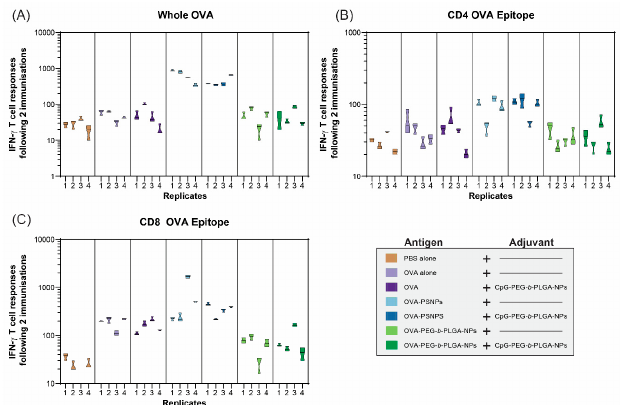
Figure 4. Interferon gamma (IFN- γ ) T-cell responses to nanovaccine formulations at Day 28. C57BL/6 mice were immunized twice, two weeks apart, intradermally at the base of the tail with the following formulations; PBS alone (Naïve), OVA alone, OVA + CpG-PEG- b -PLGA NPs, OVA-PS NPs, OVA-PS NPs + CpG-PEG- b -PLGA NPs, OVA-PEG- b -PLGA NPs, or OVA-PEG- b -PLGA NPs + CpG-PEG- b -PLGA NPs. All animals received 50 µg OVA. CpG-PEG- b -PLGA NP groups received 5 µg CpG. Graph shows IFN- γ T-cell responses to ( A ) whole OVA, ( B ) CD8+ T-cell epitope (SIINFEKL), and the ( C ) CD4 + T-helper OVA epitope (ISQAVHAAHAEINEAGR) by ELISpot assay. Individual mice are shown for each recall antigen ± experimental error from triplicate assay